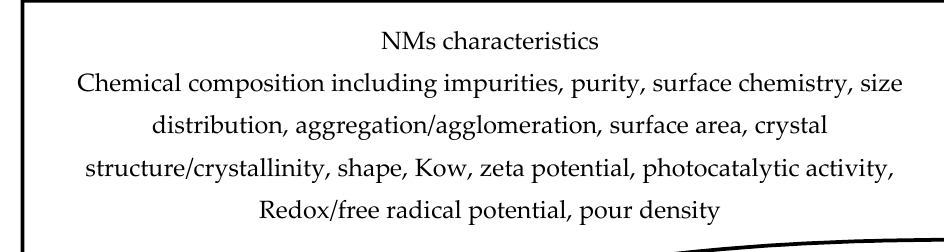
Figure 3. The NMs’ characteristics information, based on reliable measurements, is the starting point for risk assessment.